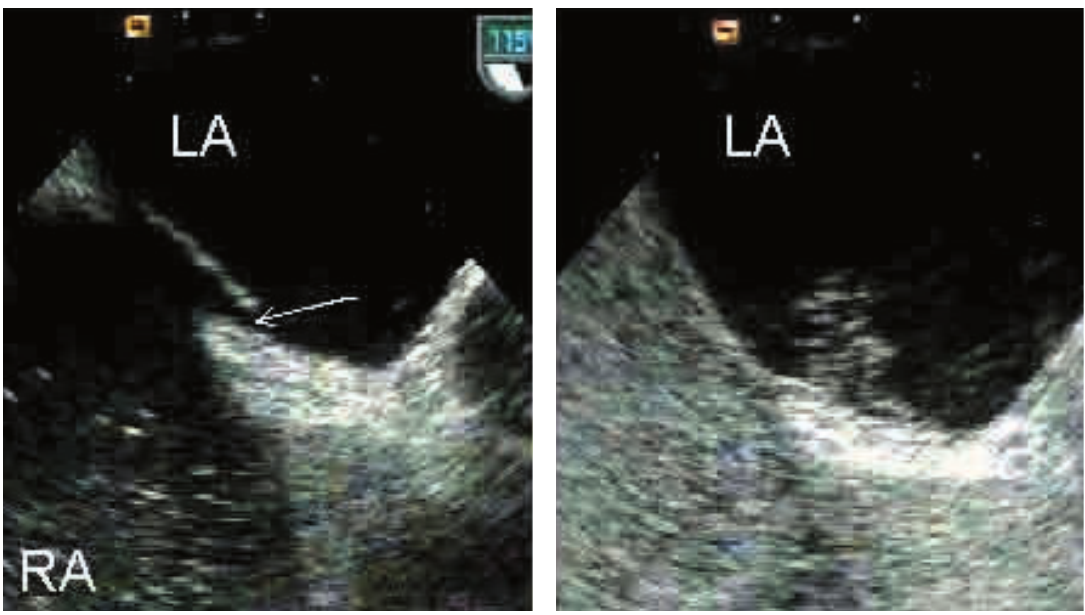
Long axis trans- oesophageal echo- cardiographic view in an individual with PFO. Panel A: Inter- atrial septum with fossa ovalis (thin- walled section be- tween the atria) and region of PFO (arrow). Echocontrast bubbles are just entering the right atrium via superior vena cava (right side of the panel: cranial). Panel B: Identical view as in panel A with the region of the atrium now filled with echocontrast bubbles. A small cloud of bubbles en- ters the left atrium directly via PFO. The diagnosis of PFO re- quires crossing of the bubbles within 4 heart beats. Other- wise, appearance